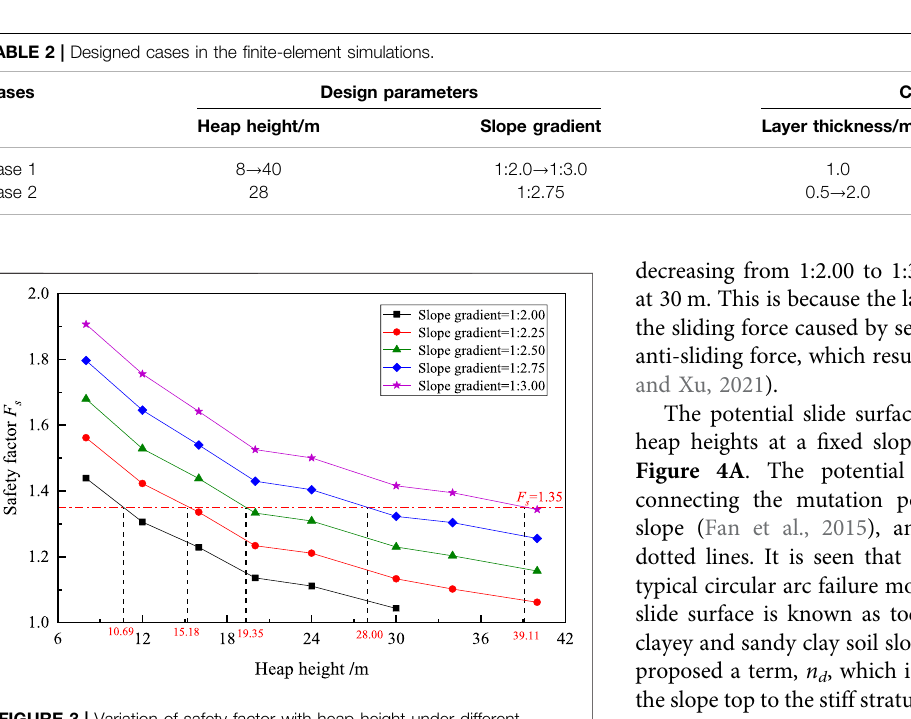
to the slope bottom, to identify the failure mode of the soil dump.